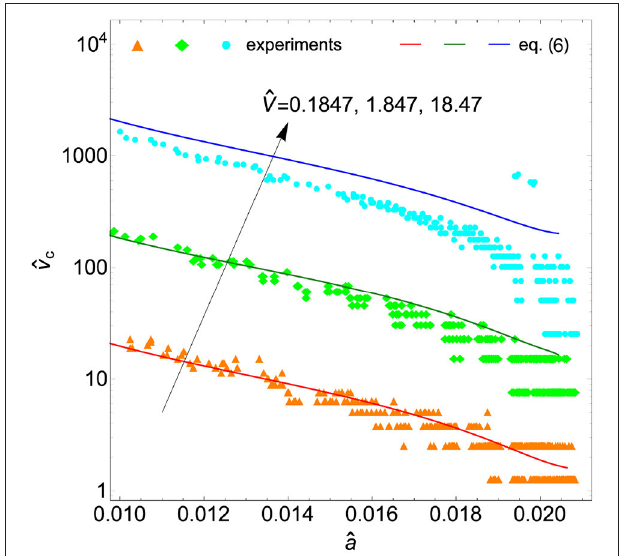
FIGURE 3 | The dimensionless contact line velocity ˆ v c as a function of the dimensionless contact radius ˆ a for different pulling velocities ˆ V = 0.1847,1.847, 18.47 ( V = 0.2, 2, 20 µ m/s). Markers denote experimental data, while solid lines refer to the prediction given by Equation (6) with the actual pulling velocity V act .